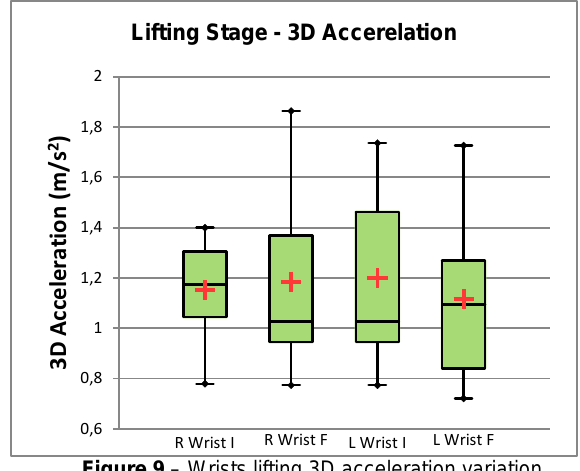
Figure 10 analysis can be divided into the following